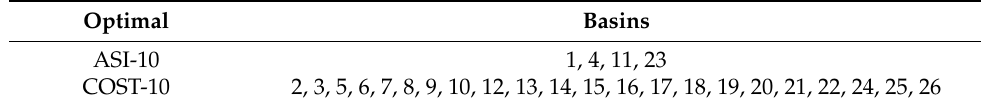
Table 9. The results of each basin about the optimal